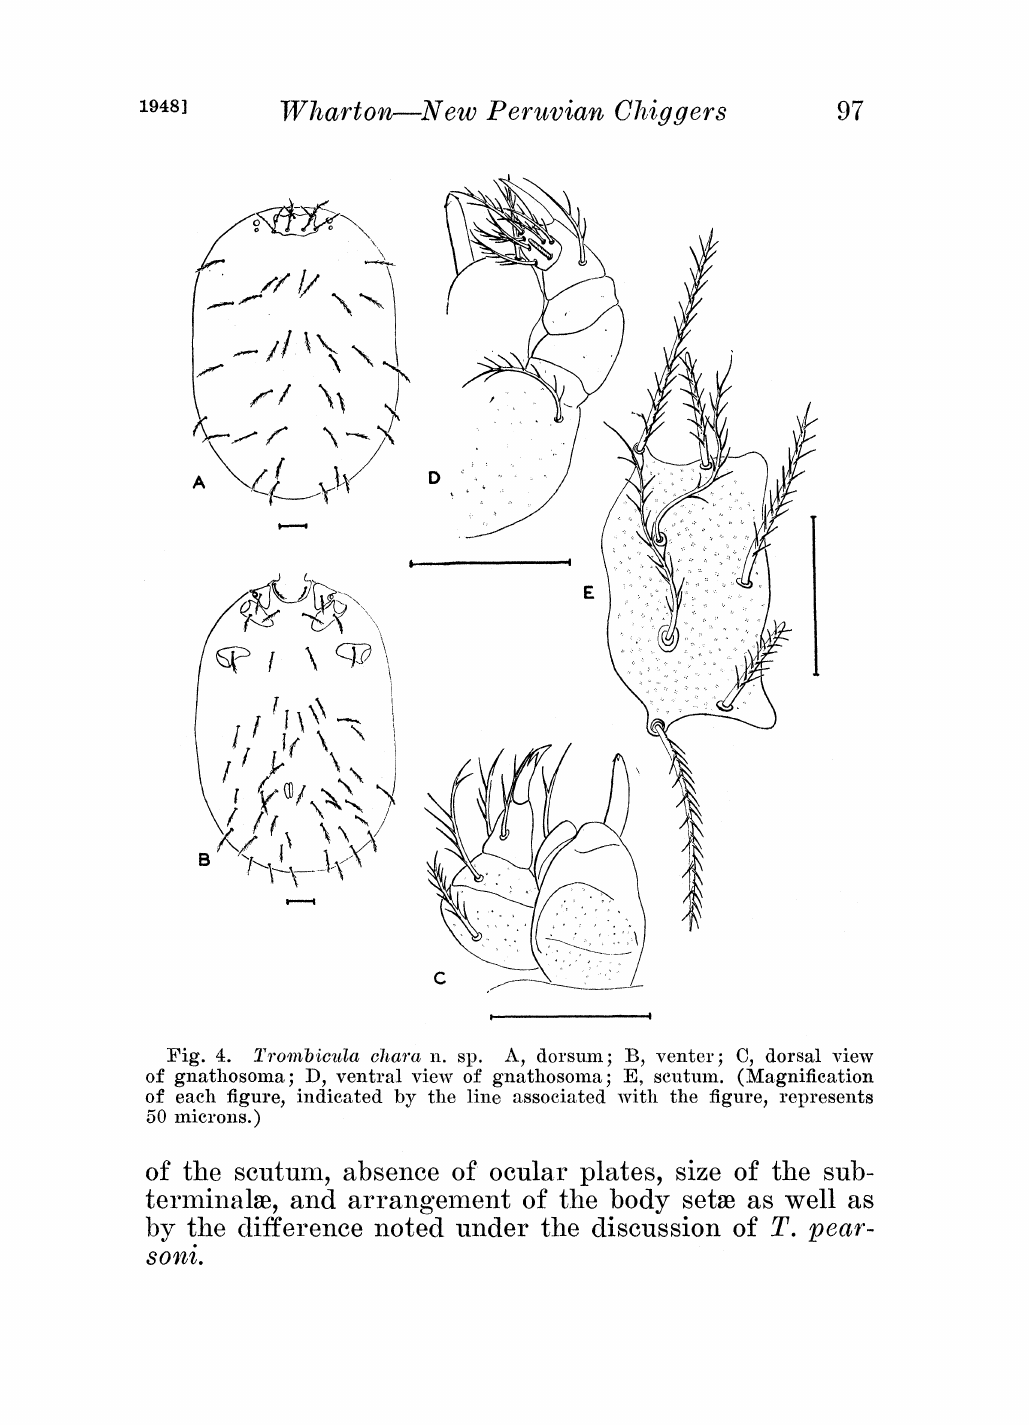
Fig. 4. Troqbicula chara n. sp. A, dorsum; B, renter; C, dorsal view of gnathosoma; D, ventral view of gnathosoma; E, scutum. (Magnification of each figure, indicated by the line associated with the figure, represents 50